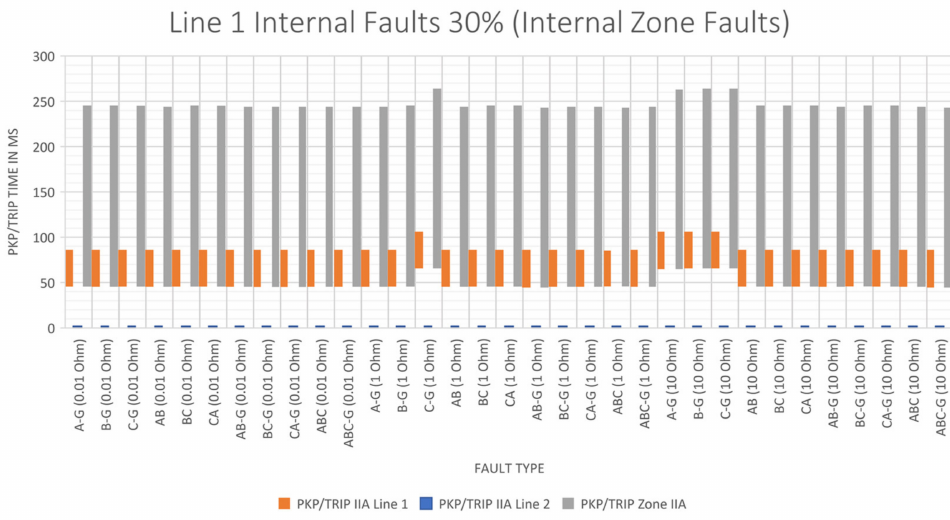
Figure 26. Internal line faults in Line 1 (30%); two reactors.